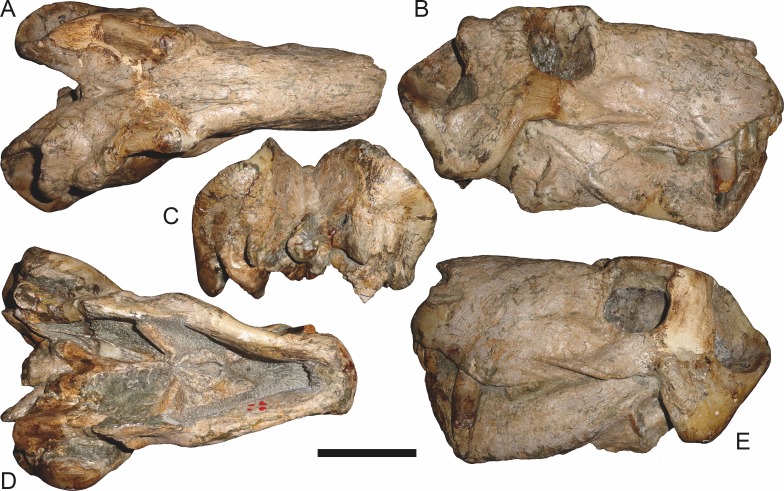
Referred specimen (RC 103) of Dinogorgon rubidgei
Broom, 1936 in (A) dorsal, (B) right lateral, (C) occipital, (D) ventral, and (E) left lateral views.Holotype of Dinogorgon oudebergensis
Brink & Kitching, 1953. Scale bar equals 10 cm.